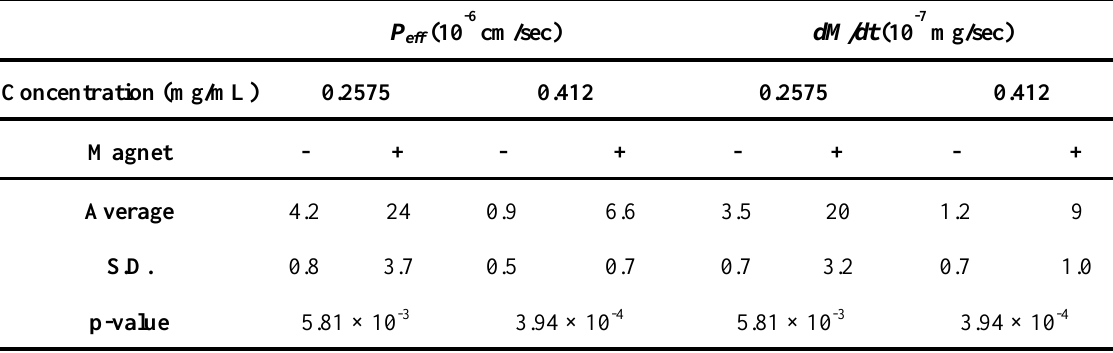
Table 2. Transport behavior of Hep-MION dispersions (0.2575 or 0.412 mg/mL) with or without an applied magnetic field. The average and standard deviation (S.D.) of three different batches are displayed. The p-values (two-tails) were assessed with two sample t- test with equal variance (significance level: p <